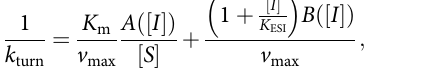
to that given here (Supplementary Methods), and we therefore refer to f T t ð Þ above as that associated with the “ two state ” model. cat Analyzing the two-state model, we fi nd A I ½ (cid:2)ð Þ and B I ½ (cid:2)ð Þ to be monotonically decreasing functions of [ I ] (See Fig. 5a & SI for ð Þ ≠ k 2 ð Þ and 0 < p < 1, explicit expressions). This is true as long as k 1 cat cat and means that A I ½ (cid:2)ð Þ ; B I ½ (cid:2)ð Þ (cid:5) 1 for all [ I ]. When the inhibitor concentrations are low, these deviations from unity are linear in [ I ]; and for high inhibitor concentrations, both A I ½ (cid:2)ð Þ and B I ½ (cid:2)ð Þ eventually plateau at a certain level. Since this level could be much lower than unity, the variation in A I ½ (cid:2)ð Þ and B I ½ (cid:2)ð Þ may strongly affect the turnover rate in Eq. (3). Consider, for example, the limit of very high substrate concentration and note that we then have classical linear relation between k (cid:4) 1 and [ I ] is then because B ð I ½ (cid:2)Þ turn is not a constant (Fig. 5b), and could thus be interpreted as a measurable telltale sign of non-Markovian kinetics. The most important consequence of the fact that non- exponential catalysis times render A I ½ (cid:2)ð Þ and B I ½ (cid:2)ð Þ dependent on inhibitor concentration is perhaps the emergence of inhibitor – activator duality. This phenomenon is illustrated in Fig. 5c where we plot the turnover rate from Eq. (3) for the two- state model. The classical theory predicts that turnover should always decrease monotonically with inhibitor concentration, but here we fi nd that this is not always the case. Speci fi cally, we observe that for certain parameter choices (particularly when ð Þ (cid:6) k 2 ð Þ , but also when differences between catalytic rates are k 1 cat cat not as drastic), turnover could increase with inhibitor concerta- tion in a certain concentration range. This non-intuitive behavior is most pronounced at low-to-moderate inhibitor concentrations, and we see that at high inhibitor concentrations — where A I ½ (cid:2)ð Þ and B I ½ (cid:2)ð Þ are close to their asymptotic values — normal behavior is recovered (increasing inhibitor concertation lowers the turn- over rate).